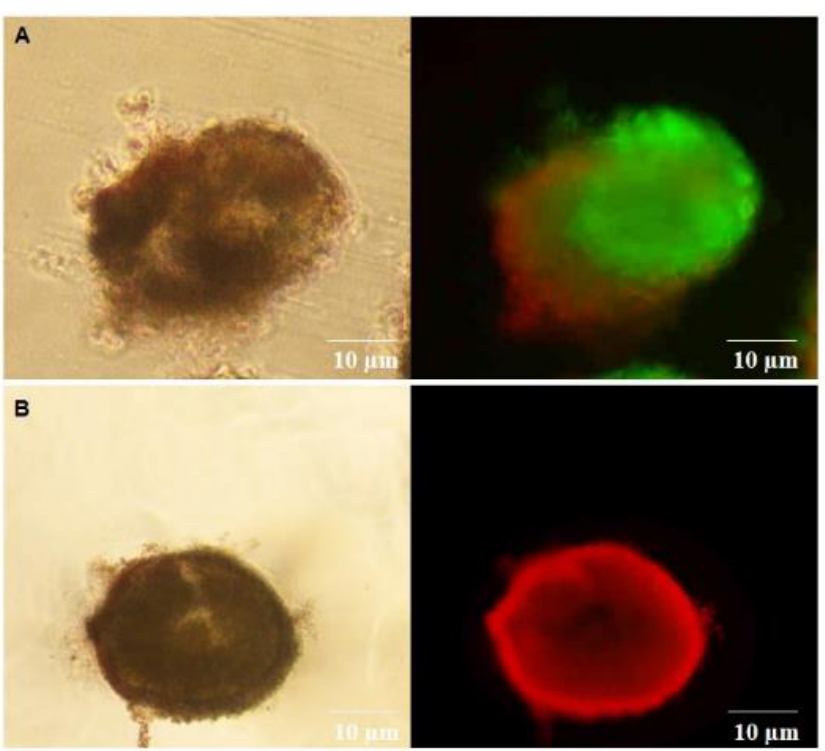
Figure 11. The valuation of follicular viability after staining with calcein-AM (green- viable follicle) and ethidium homodimer-1 (red-non-viable follicle). ( A ) follicle cultured with both CIMI and DOXO; ( B ) follicle cultured with DOXO. Scale bars represent 10 μm.